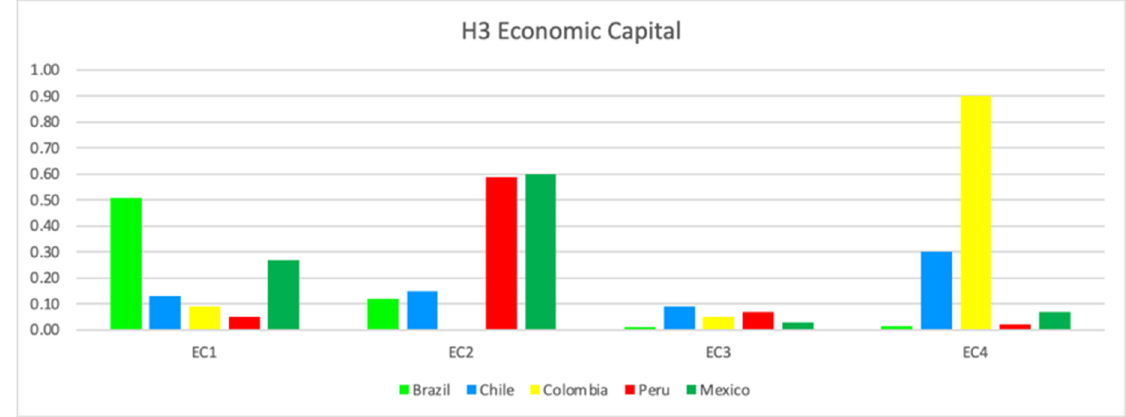
Figure 4. Economic Capital (EC). Source: Own elaboration based on [45].